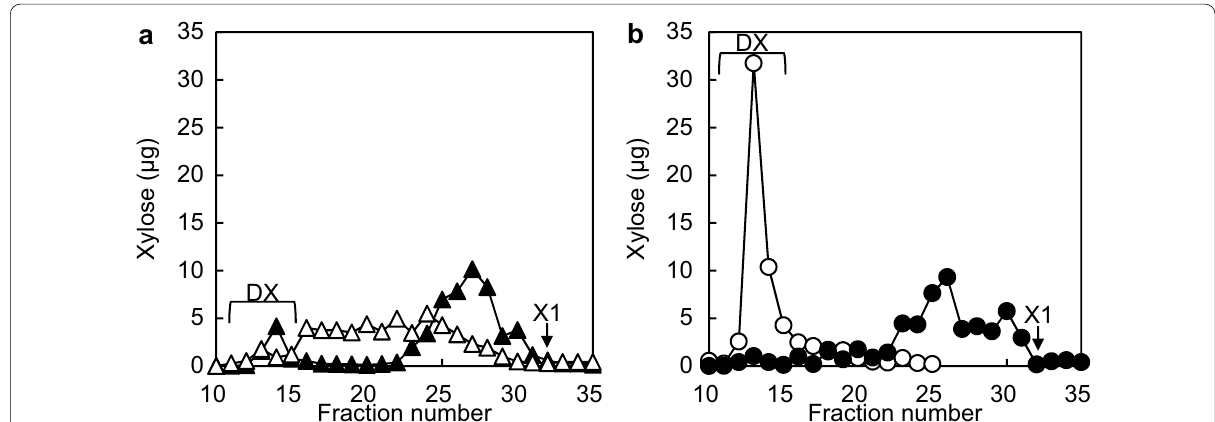
Fig. 5 Gel filtration of DX and the hydrolysates from StXyl10, StXyl11 and their combination. The hydrolysates were separated with a Superdex peptide 10/300 GL column. The amounts of each sugar were detected by the phenol-sulfate method. a White filled circle DX; Black filled circle StXyl10 and StXyl11; b White filled triangle StXyl10; White filled square StXyl11